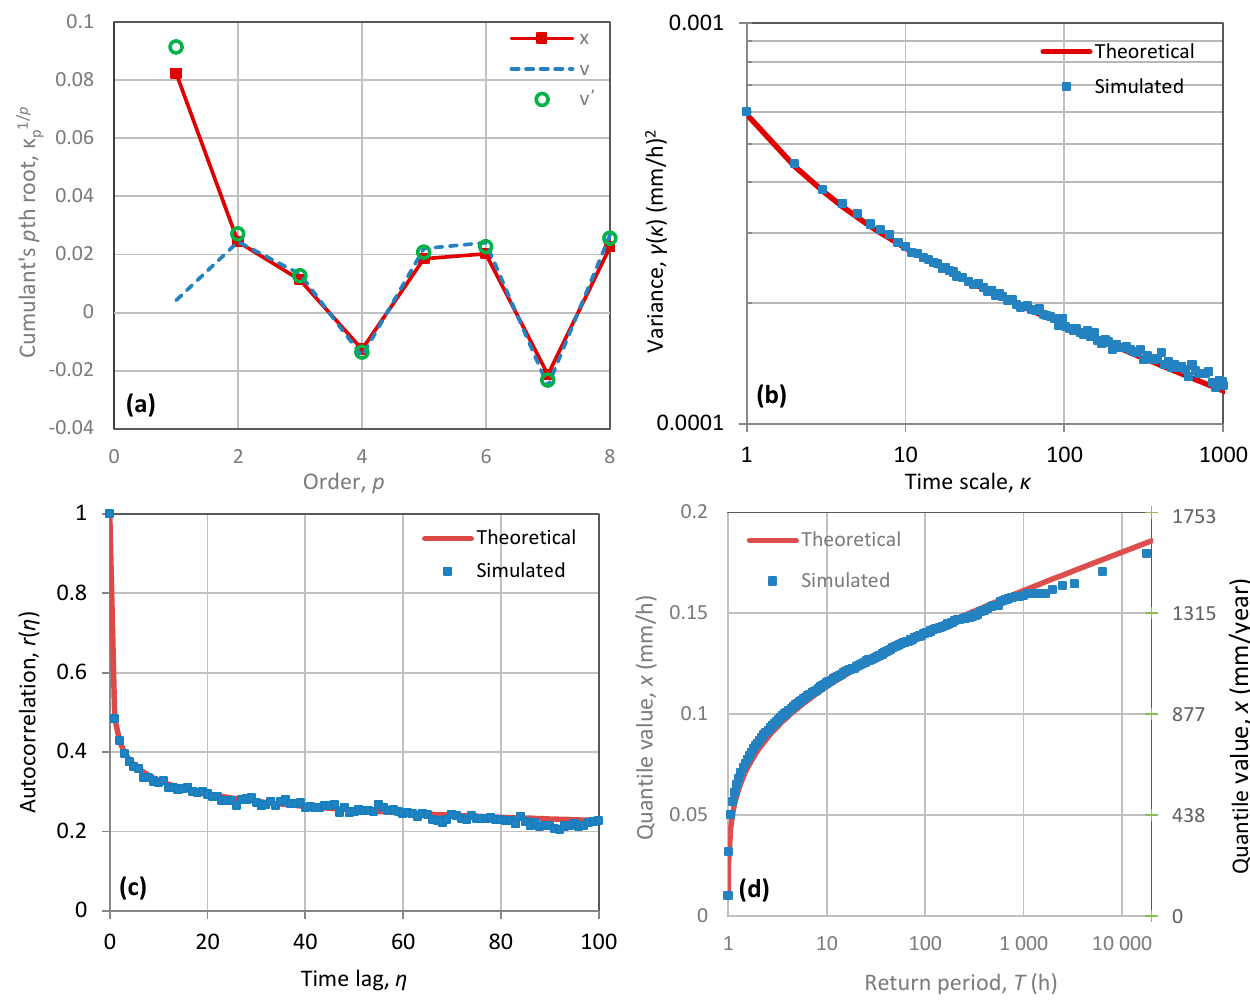
Figure 8. Graphical depiction of the results of the simulation application for a real-world case study for the precipitation process in Bologna at the annual time scale, modelled as a persistent FHK process with PBF distribution: ( a ) cumulants; ( b ) climacogram; ( c ) autocorrelogram; ( d ) marginal distribution.